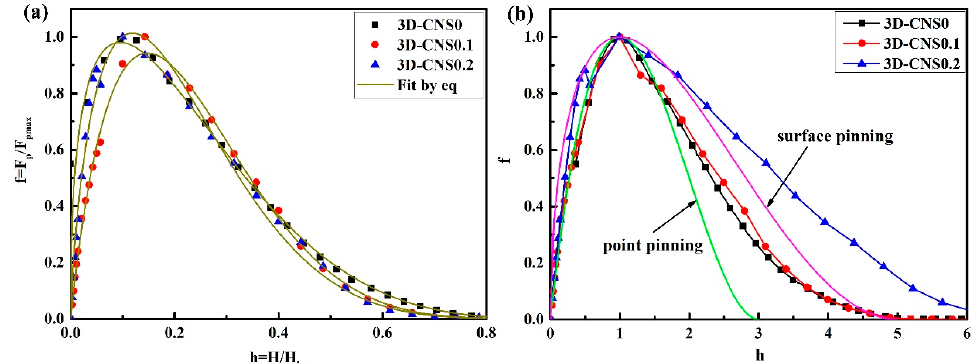
Figure 10. ( a ) Fitting of Hughes pinning model and ( b ) variation curve of normalized pinning force density with magnetic field for composite samples doped with different 3D-CNS contents. Table 3. Comparison of fitting values of Hughes model.